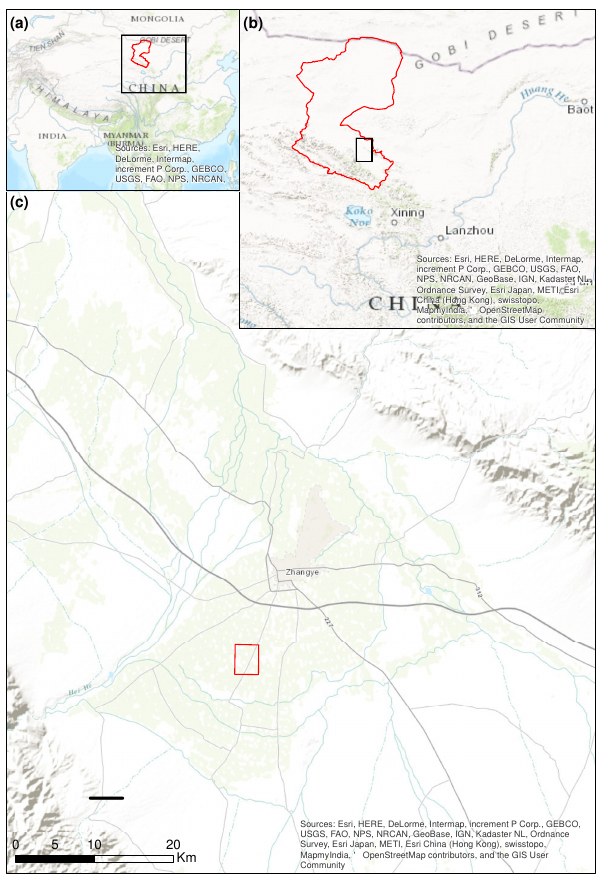
Figure 1. ( a , b ) Location map of the Heihe river basin in China. ( c ) Footprint of the WiDAS and LIDAR acquisition in the Yingke oasis experimental area, where the station is